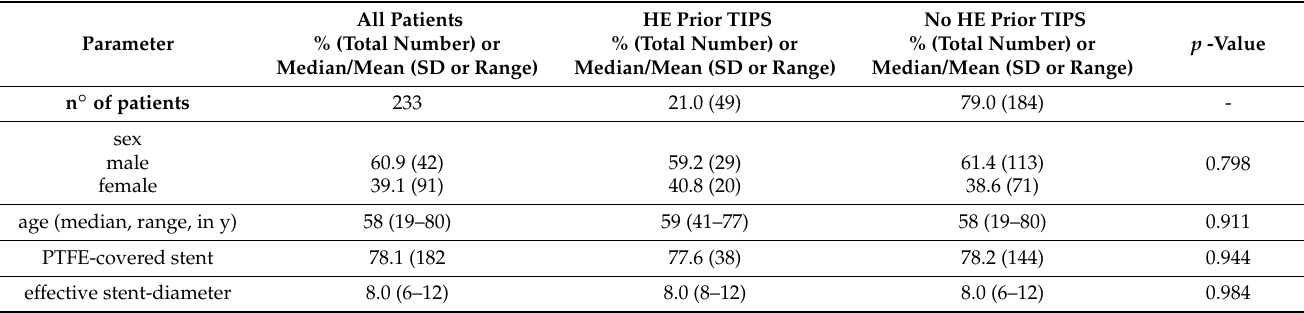
Table 1. Baseline